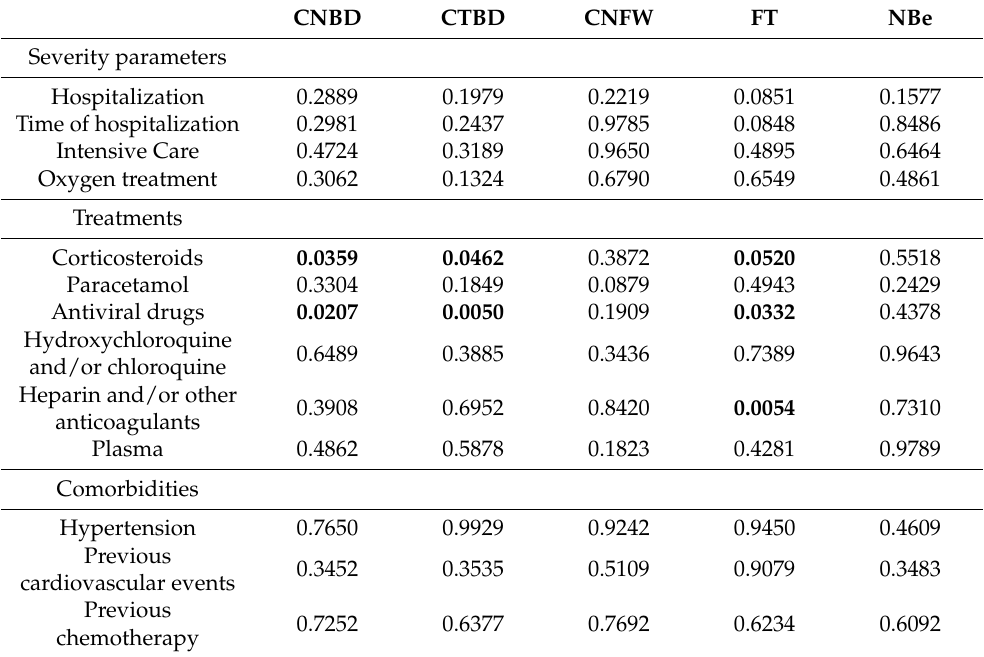
Table 4. Relationship between CCM corneal and systemic clinical data in COVID-19 group patients ( p -values from multiple regression analysis).